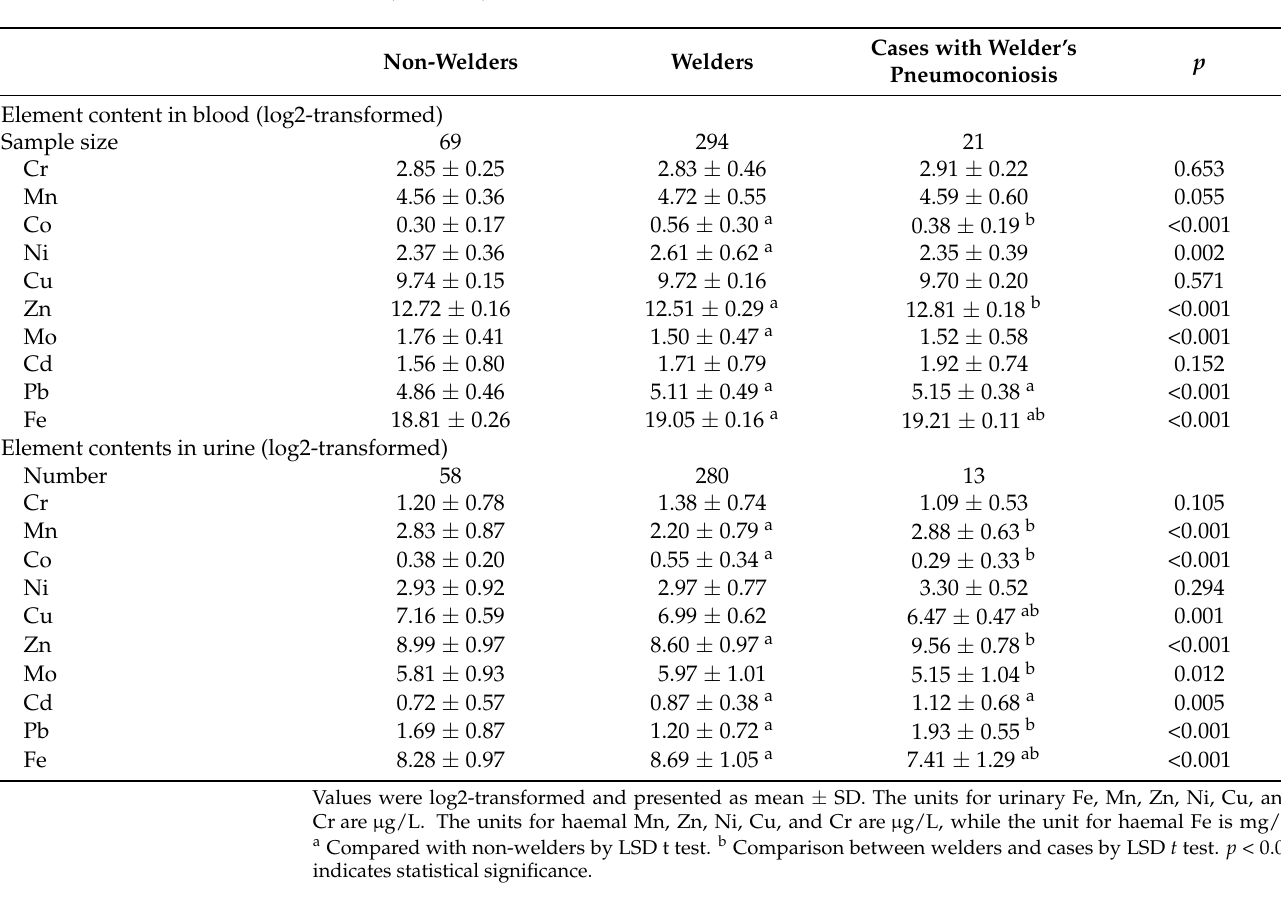
Table 2. Distributions of 10 haemal and urinary metal concentrations in cases with welder’s pneumo- coniosis, welders, and non-welders.